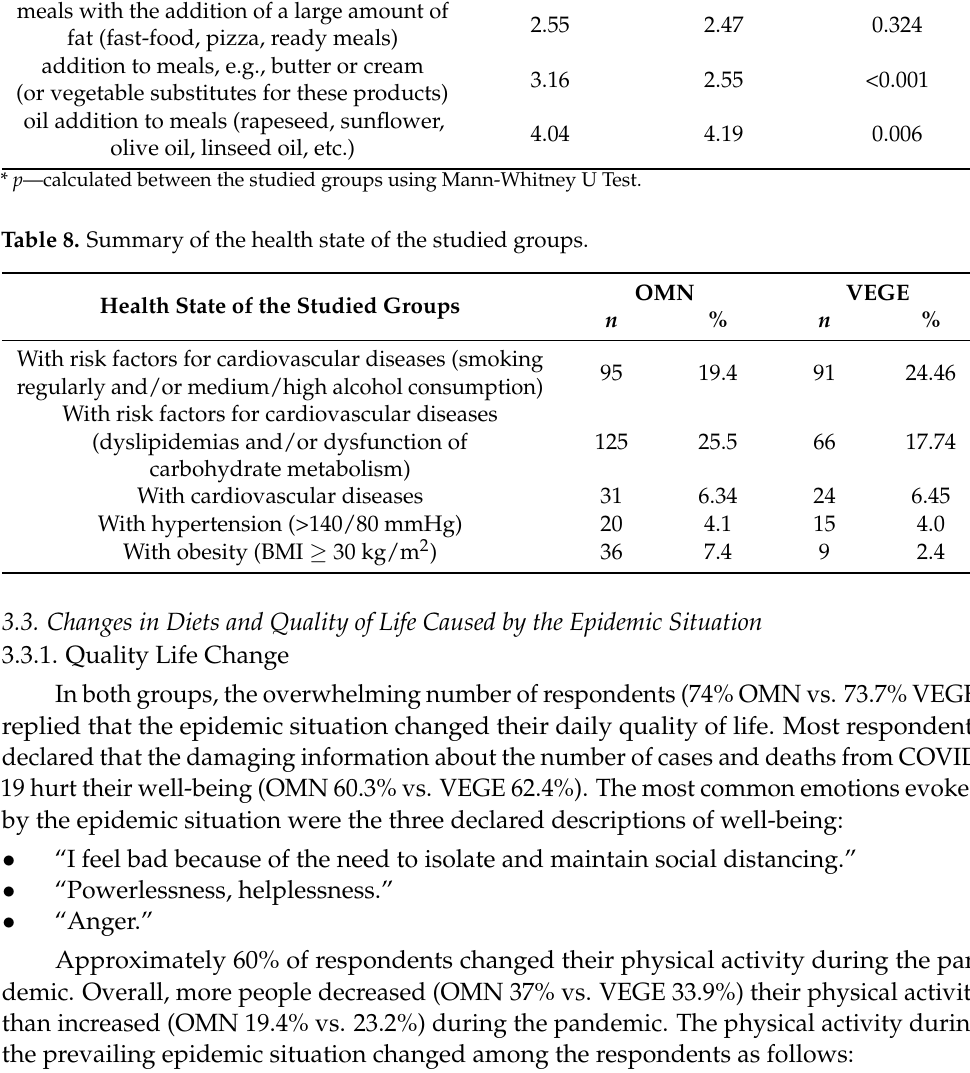
Table 7. The frequency of consumption of products/meals that are a source of fat. Responses OMN VEGE p * deep fried meals 2.28 2 <0.001 2.55 0.324